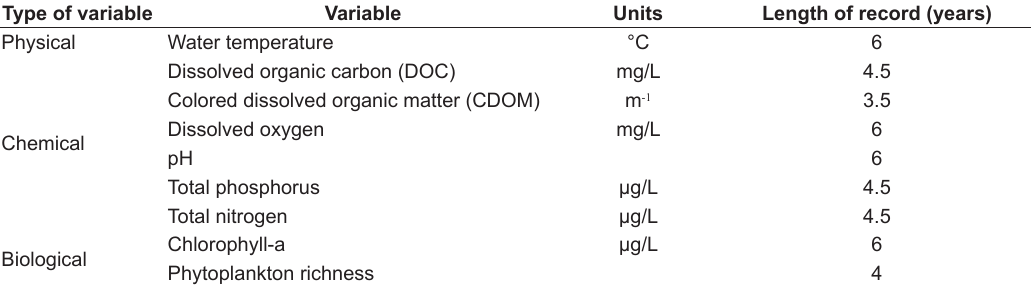
Table 2. Physical, chemical and biological variables included in the study.